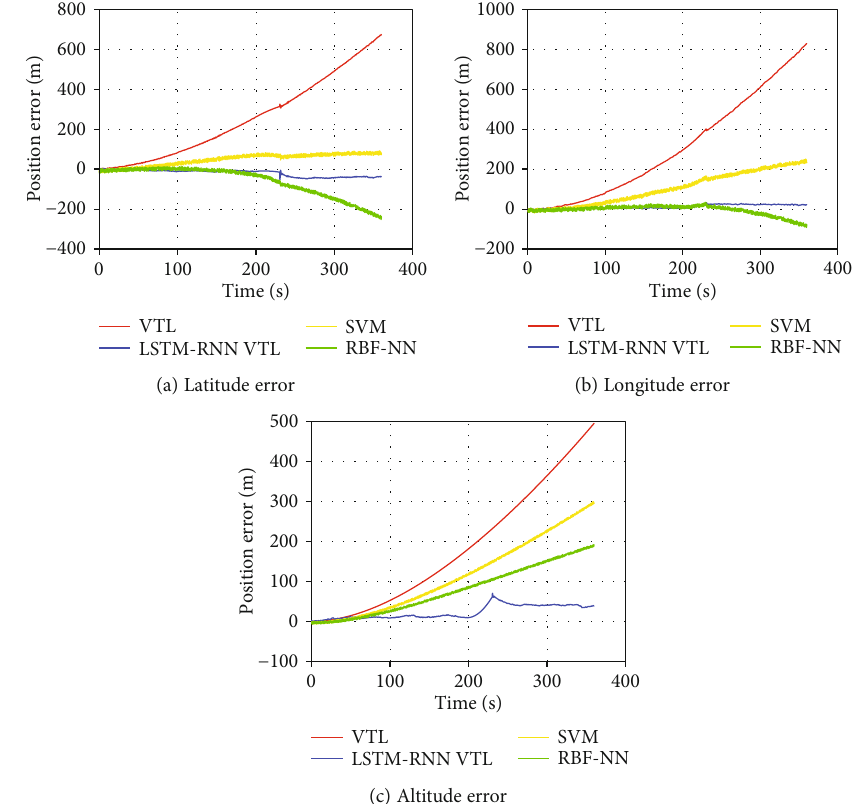
Figure 11: Position errors (two available